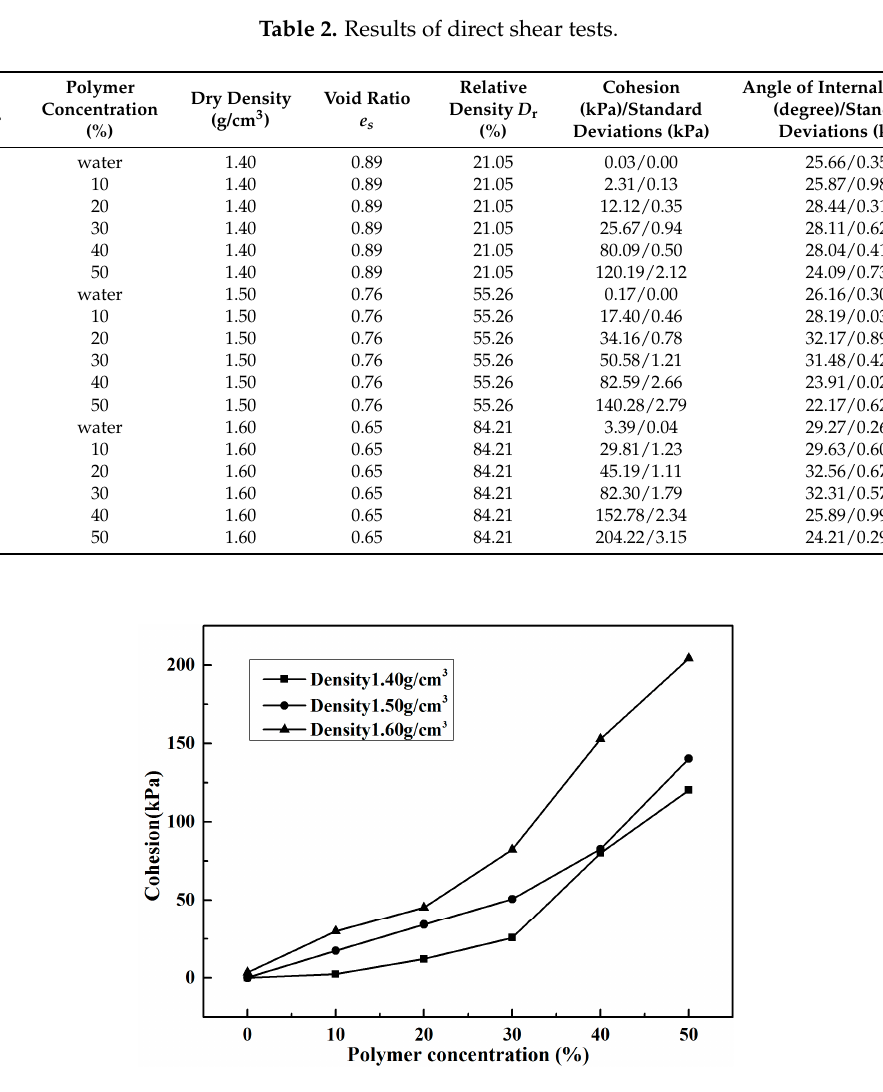
Table 2. Results of direct shear tests.